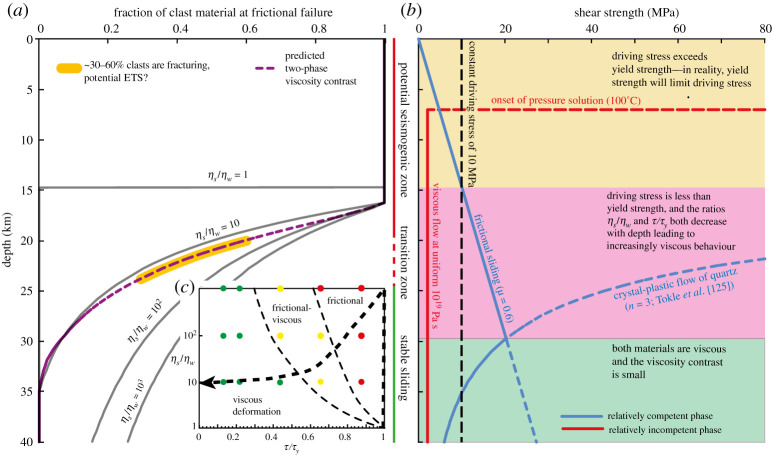
Illustrative example of strength and deformation mode in a two-phase fault zone. In (a) the fraction of competent material at frictional yield is plotted against depth for various viscosity contrasts (ηs/ηw). (b) shows the specific example used, which is a simplified subduction thrust, involving a weak phase (red line) with viscosity 1019 Pa s deforming by pressure solution at temperatures above 100°C, and a competent phase (solid blue line) controlled by Byerlee friction and a quartz flow law [125]. The black dashed line shows a driving stress of 10 MPa. Inset (c) depicts the approximate path of subducting rocks with increasing depth along the subduction interface in the deformation style map presented in figure 5e.(Online version in colour.)